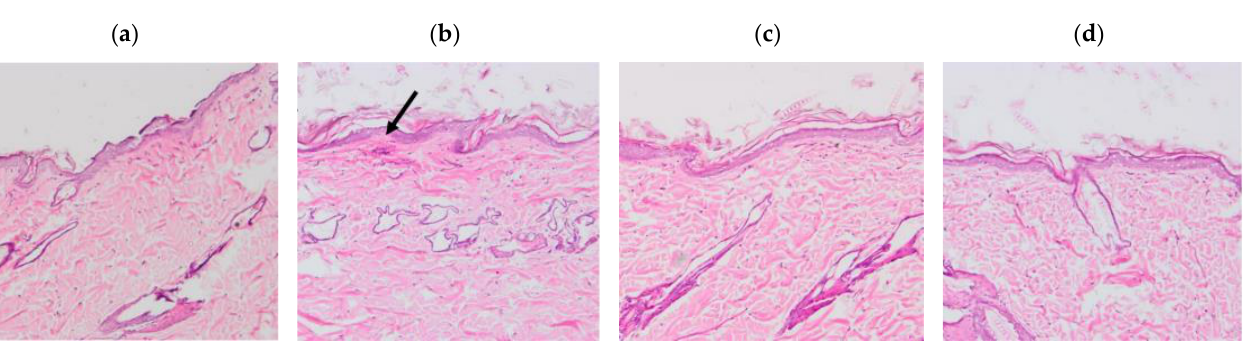
Figure 6. Erythema shown as skin color sequence section, using APR-Squalene solution and Blank- Squalene solution. Colors are reproduced from the Median values of RGB codes.